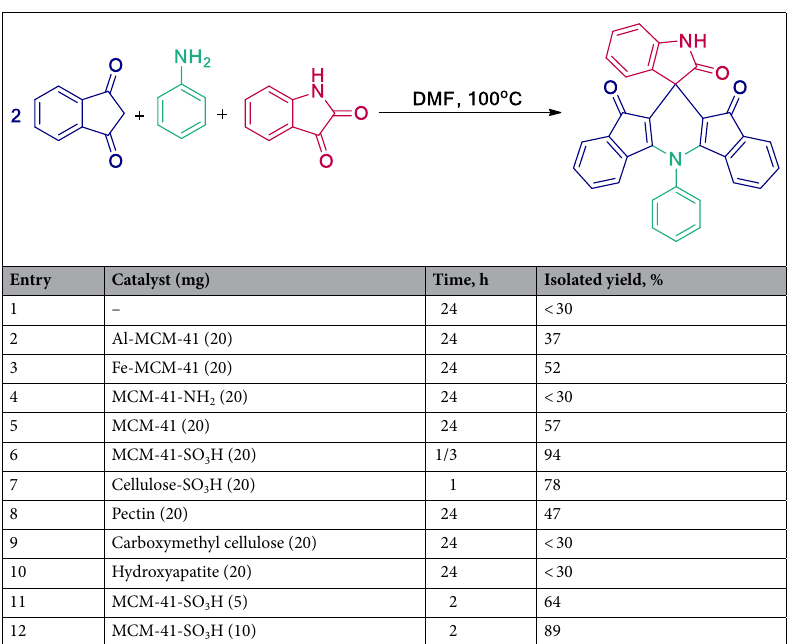
in Fig. 2. The bands at 1325 and 1288 cm −1 correspond to the asymmetric and symmetric stretching vibrations of the SO 3 H group. A wide band in the area of 3400–3200 cm −1 is related to the O–H stretching vibration of the hydroxyl groups. Moreover, stretching vibrations of Si–O–Si are indicated by sharp bands at 1170 and 850 cm −165,66 . The SEM images of the fresh and recovered MCM-41-SO 3 H have been shown in Fig. 3 and confirm the nanoscale size of the synthesized particles. The size of most particles was in the range of 50–90 nm. As can be seen, the particles are aggregated, due to the strong hydrogen bonding between the acidic moieties. The EDX analysis of the fresh catalyst proved the presence of O, Si, and S atoms in the MCM-41-SO 3 H structure with a uniform distribution of the sulfonic acid groups (Fig. 4).